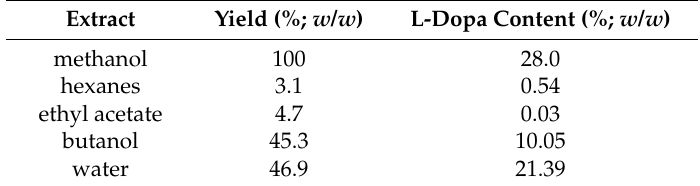
Table 1. Levodopa (L-dopa) content for each Mucuna pruriens seed extracts as determined by